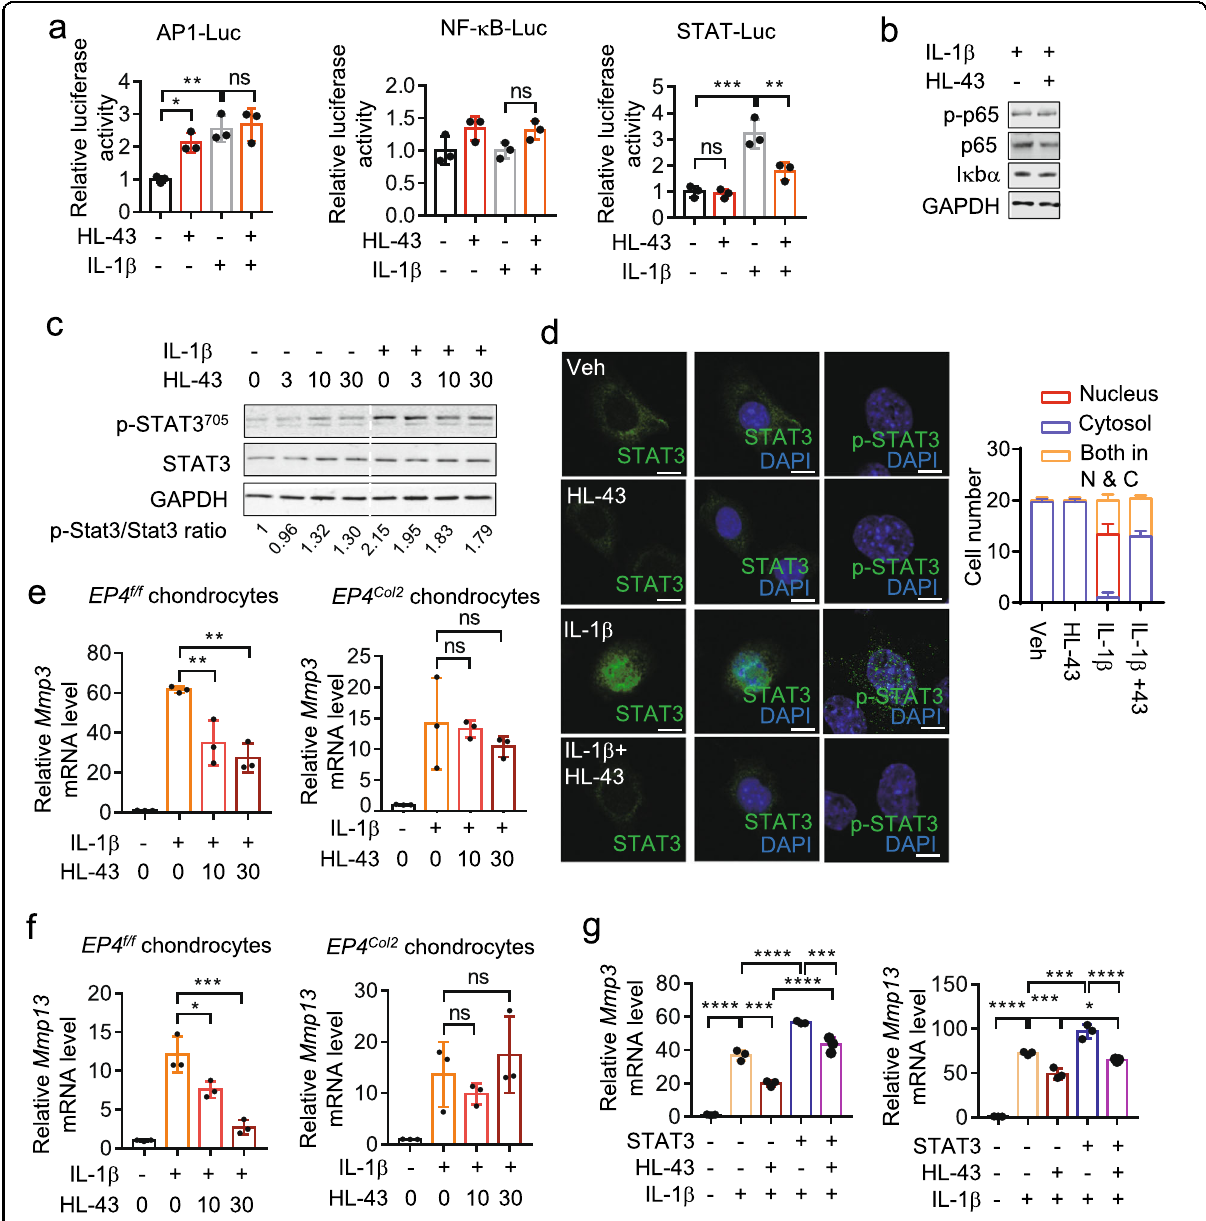
Fig. 8 EP4 antagonist HL-43 suppressed cartilage catabolism through STAT3 signaling. a HL-43 inhibited STAT luciferase reporter activity, but not AP1 or NF- κ B activity. After transfecting with the AP1-Luc, NF- κ B-Luc, Stat-Luc reporter, the ATDC5 cells were treated with or without 2ng/ml IL-1 β and 30 μ M HL-43 for 6h. The cell lysates were subjected to Dual-Luciferase assays ( n = 3). b Primary culture of mouse articular chondrocytes was treated with IL- 1 β and 30 μ M of HL-43 for 1h. p-P65, P65, I κ B α protein levels were detected by Western blotting. c Primary culture of mouse articular chondrocytes was treated with or without 2ng/ml IL-1 β and the indicated concentrations ( μ M) of HL-43 for 1h. p-STAT3 705 , STAT3, and GAPDH protein levels were detected by Western blotting. Protein bands in the blot were quanti fi ed by densitometry and analyzed using Image J. The numbers indicate grayscale ratios of p-STAT3 705 /STAT3. d HL-43 inhibited IL-1 β -induced STAT3 and p-STAT3 nuclear translocation. Immuno fl uorescence staining of STAT3 and p-STAT3 subcellular localization of ATDC5 cells (left). Cells were treated with or without HL-43 (30 μ M) and 5ng/ml IL-1 β for 24h. Scale bars, 10 μ m. Statistical analysis for STAT3 cellular distribution by confocal microscope (right). e , f HL-43 regulated expression of Mmp3 and Mmp13 in an EP4 dependent manner. qRT-PCR analysis of Mmp3 ( e ) , Mmp13 ( f ) expression in primary articular chondrocytes isolated from new born EP4 f/f or EP4 Col2 mice that were treated with or without 2ng/ml IL-1 β and indicated concentrations ( μ M) of HL-43 for 24h ( n = 3). g qRT-PCR analyses of Mmp3, Mmp13 expression in ATDC5 cells that transfected with or without STAT3 plasmids, then treated with or without 2ng/ml IL-1 β , 30 μ M of HL-43 for 24h. Unless otherwise stated, graphs show means ± s.d., * P <0.05, ** P <0.01, *** P <0.001, **** P <0.0001 by one-way ANOVA with multiple comparison using Tukey method to compare between speci fi c